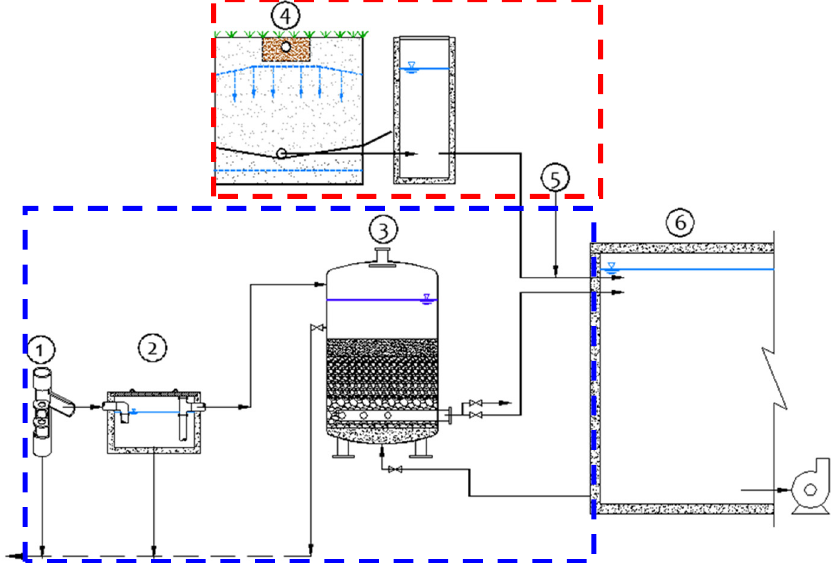
Figure 4. Schematic representation of the treatment systems for rainwater and greywater. In red, the system for greywater treatment; in blue, the operations for rainwater treatment.